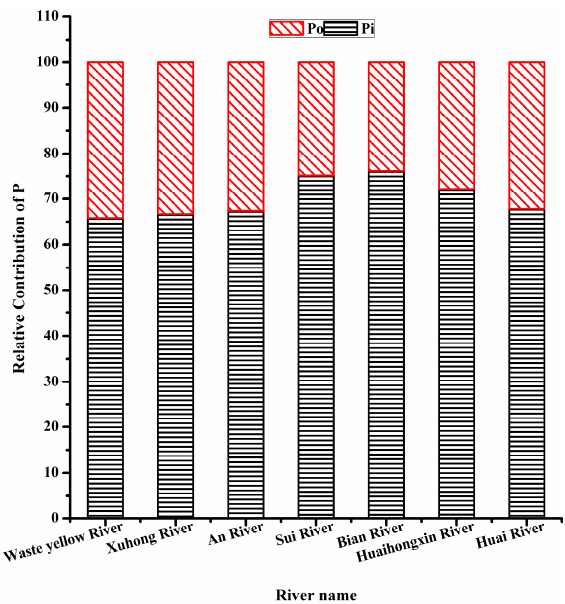
Figure 3. Concentrations of P fractions in the sediments of the seven rivers. Organic phosphorus (Po), inorganic phosphorus; (Pi), phosphorus (P).